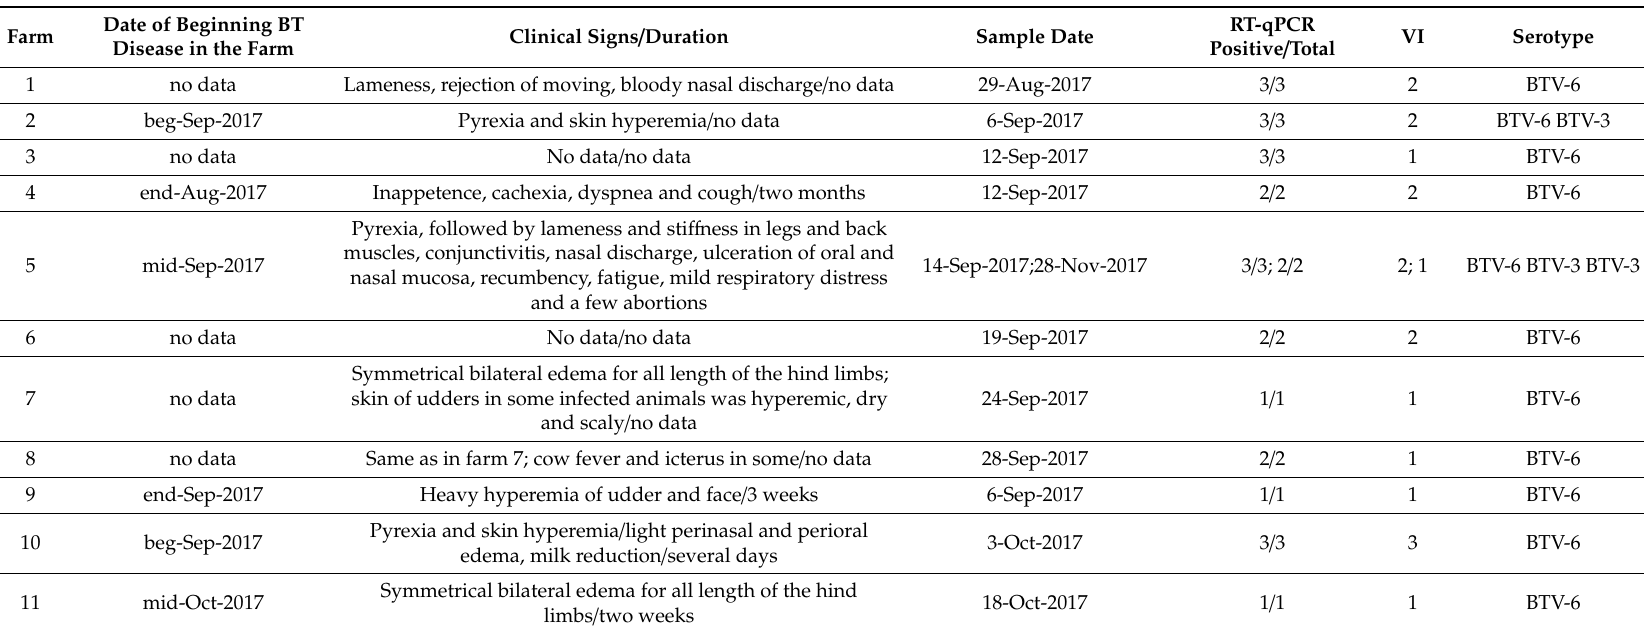
Table 4. Clinical signs and virus isolation in BTV-6 a ff ected cattle and sheep